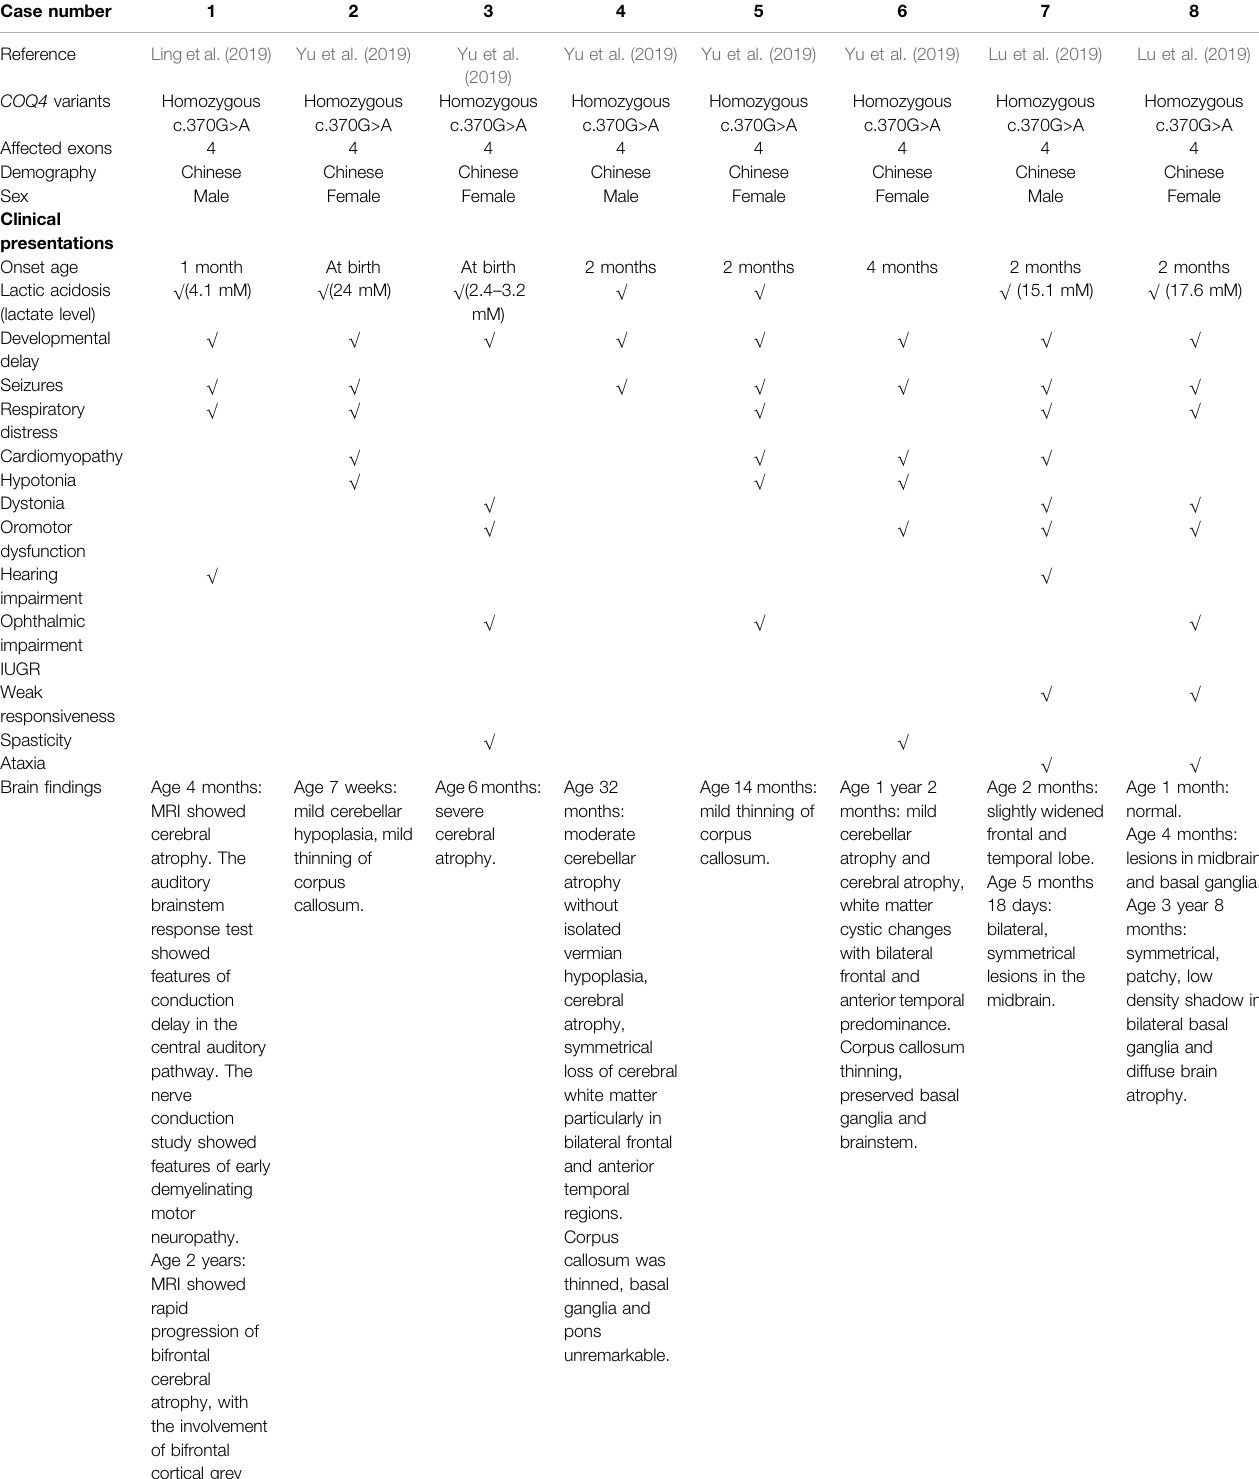
TABLE 3 | Clinical presentation, treatment, outcomes, and brain fi ndings for patients with East Asian-speci fi c COQ4 c.370G > A